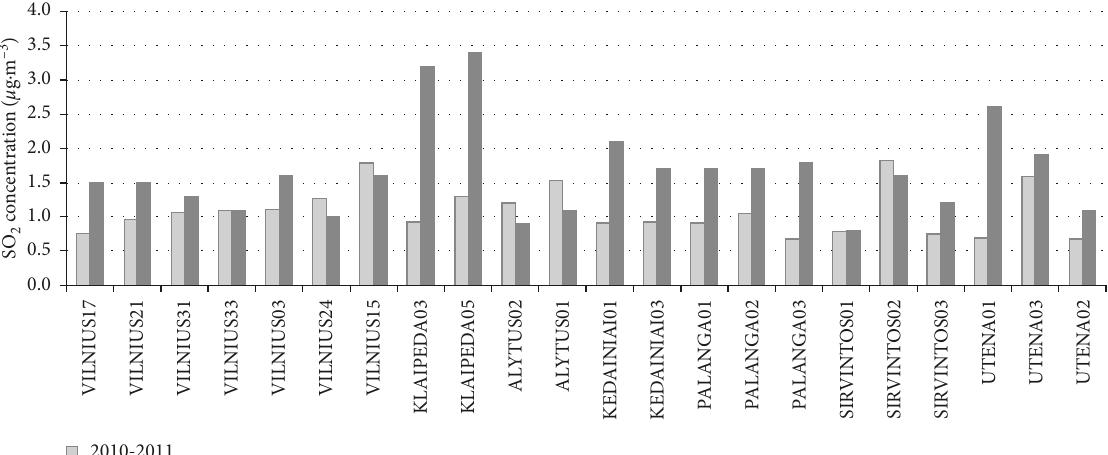
Figure 9: Time series of mean SO